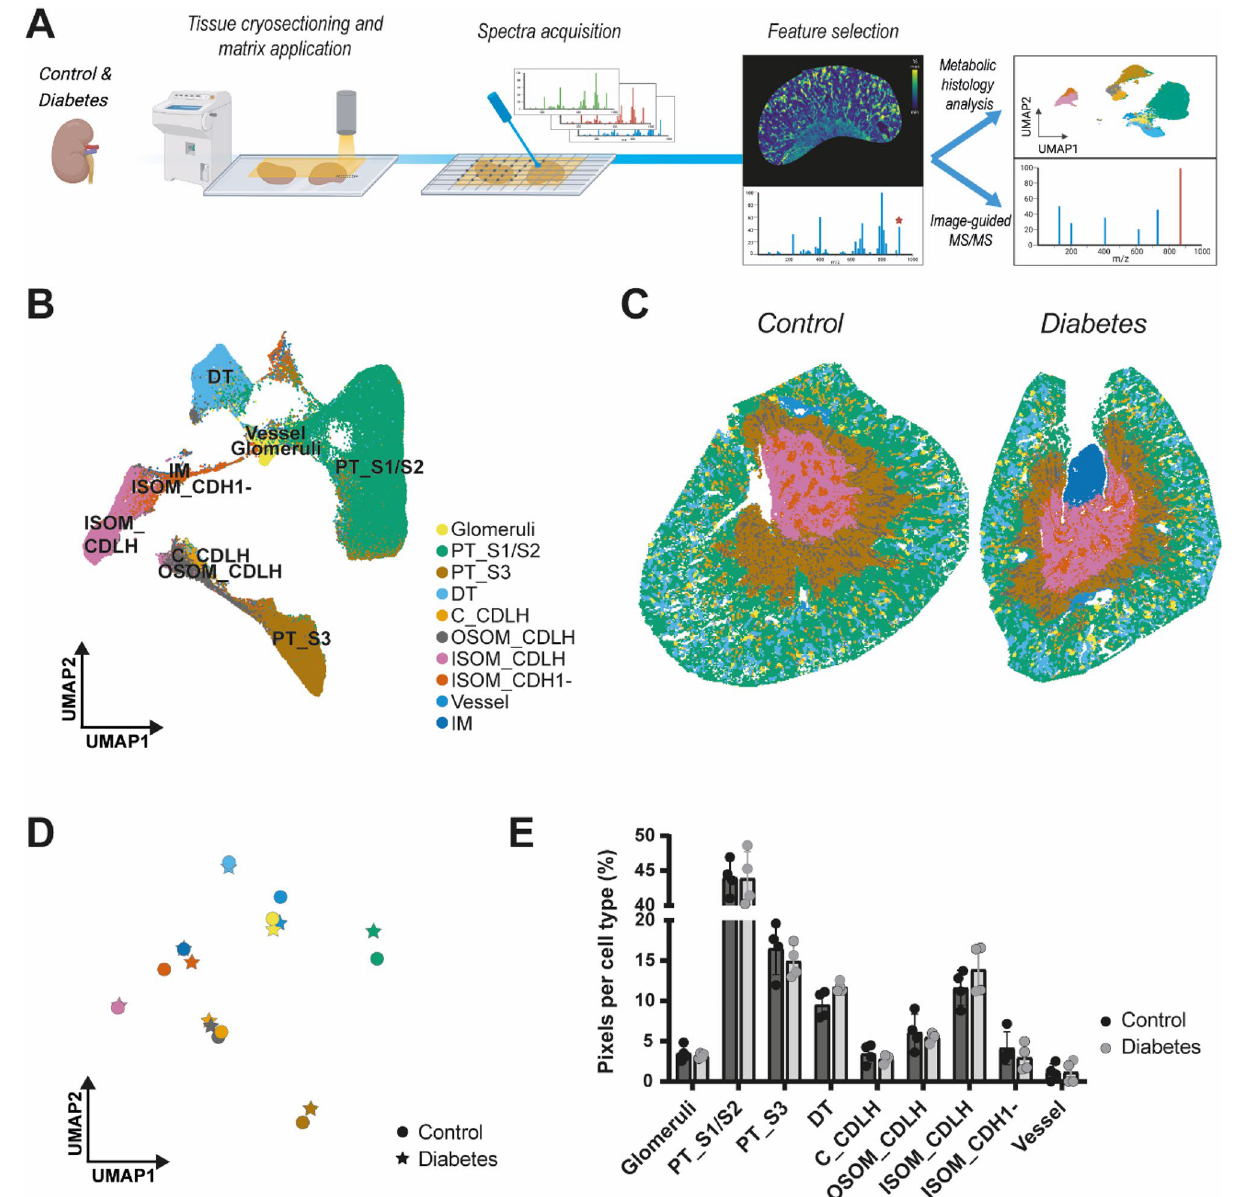
Figure 2. Metabolic histology of control and diabetes renal tissue. ( A ) Experimental workflow for in situ metabolic histology analysis of control and diabetic mouse. ( B ) Metabolic heterogeneity in the mouse kidney, visualized in a Uniform Manifold Approximation and Projection (UMAP) plot of MALDI-MSI data ( n = 4/ group). ( C ) Metabolic histology of control and diabetic renal tissue (example), identifying ten different renal cell types. ( D ) Visualization of the cluster centroids of the metabolic histological identified renal cell types, showing similarity between the control and diabetic renal clusters. ( E ) Relative contribution of the various renal cell types to the total pixel population in the control and diabetic mouse